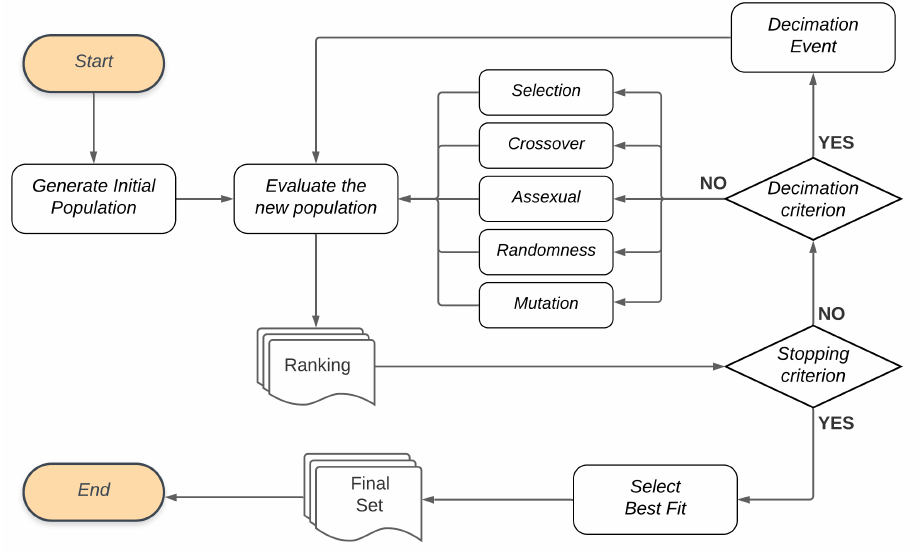
Figure 6. Genetic Algorithm